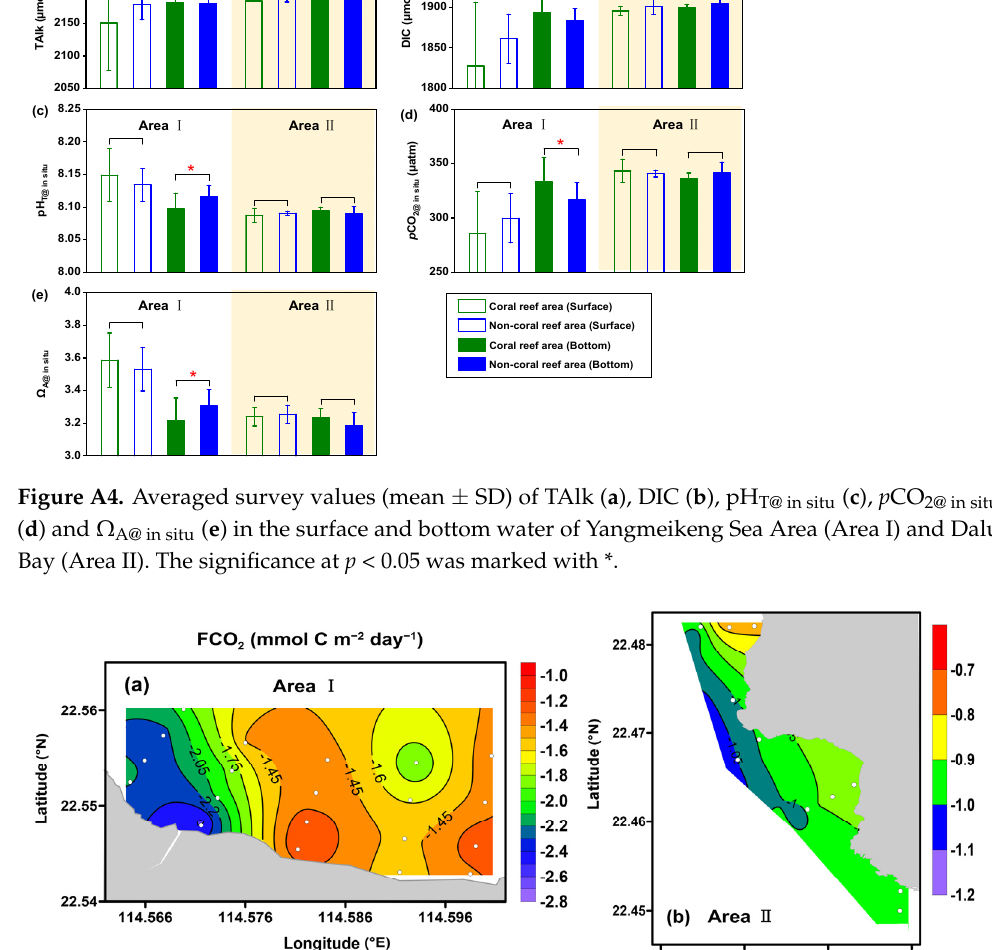
Figure A5. The air–sea fluxes of CO 2 ( F CO 2 , mmol m − 2 day − 1 ) of Yangmeikeng Sea Area (Area I) ( a ) and Dalu Bay (Area Ⅱ ) ( b ).